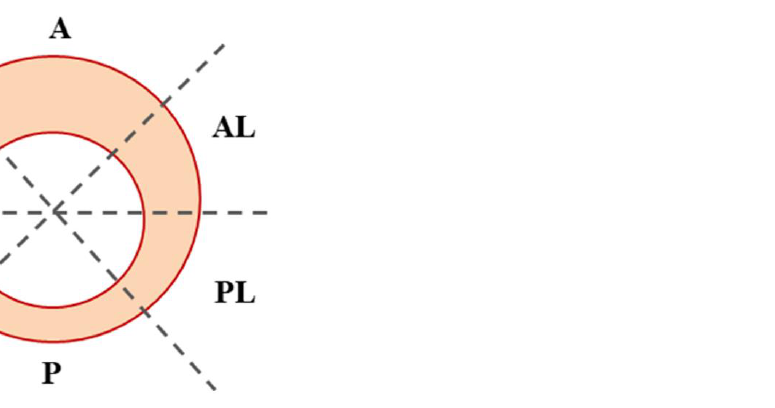
Figure 1. Map of the ascending aorta segmentation. Six segments were cut for each aortic sample, i.e., anterior (A), anterior-right (AR), posterior-right (PR), posterior (P), posterior-left (PL), and anterior-left (AL), and preserved for analyses.